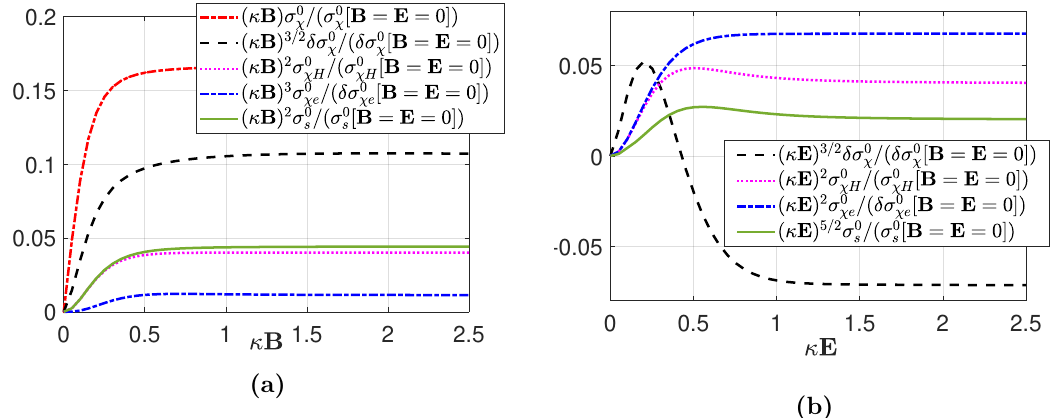
Figure 2. Normalised zeroth order TCs: (a) (cid:20) E = 0 and (b) (cid:20) B = 0.